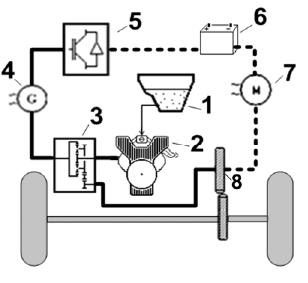
Fig 1. Parallel hybrid vehicle: